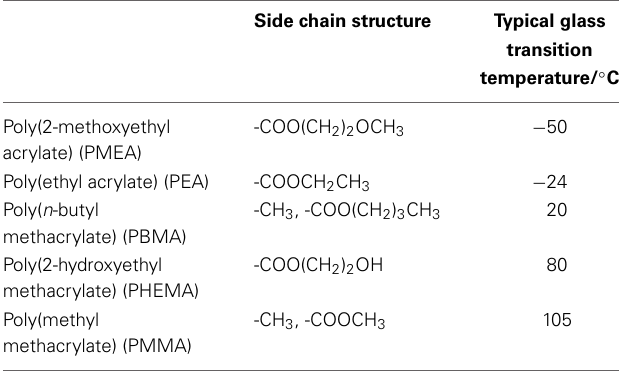
Table 1 . In order to clarify the spectral variations, the shapes